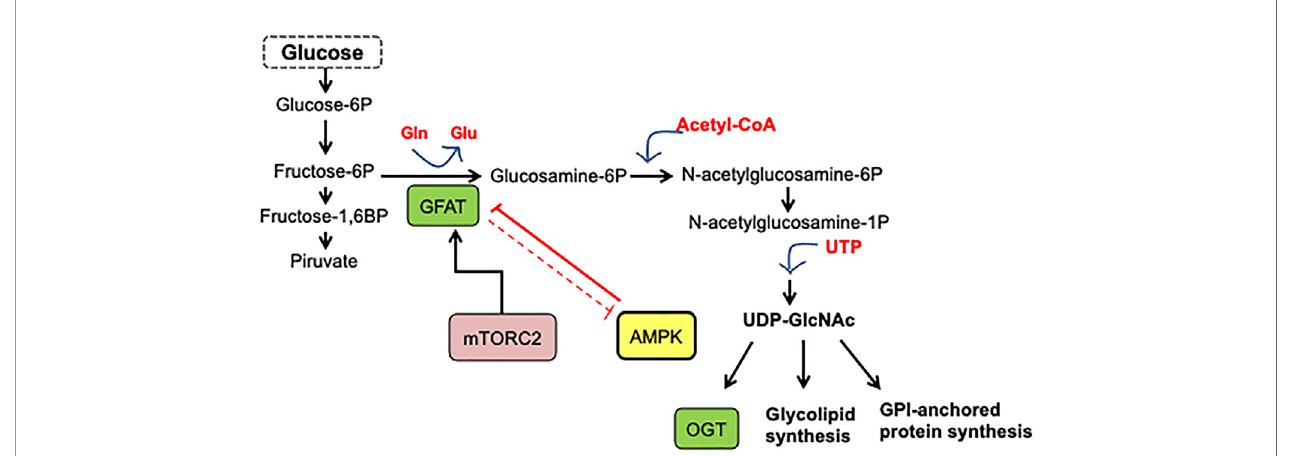
FIGURE 1 | Hexosamine biosynthetic pathway. A fraction (3 – 5%) of glucose incoming the cell is shunted through the hexosamine biosynthesis pathway. In this pathway, fructose-6-phosphate is converted to glucosamine-6-phosphate by the glutamine/fructose-6-phosphate amidotransferase (GFAT), the gate-keeper enzyme of the route. The main product of the pathway is UDP-GlcNAc, which is the substrate for O-GlcNAc